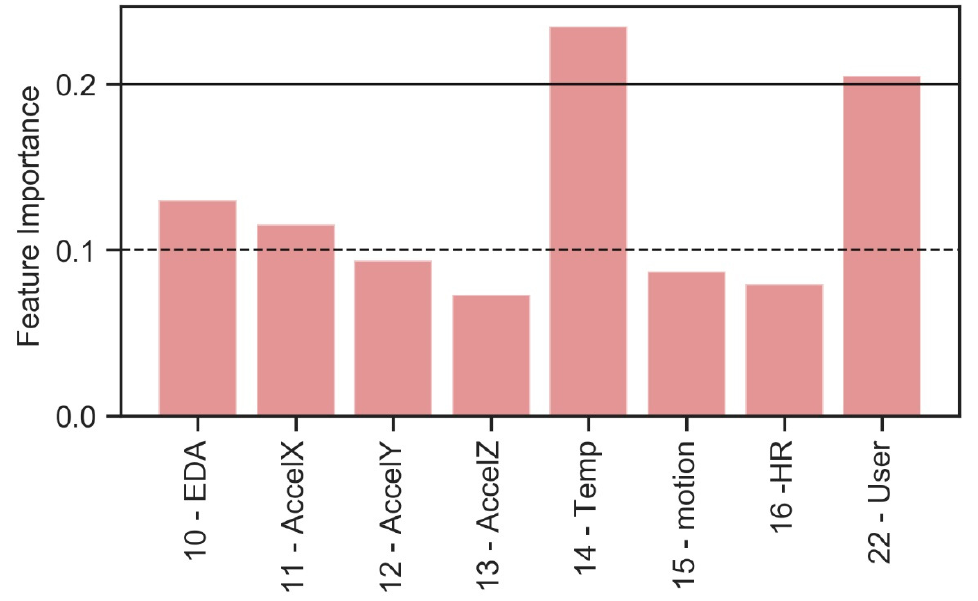
Figure 8. Feature importance—biometric parameters for plant configuration identification.